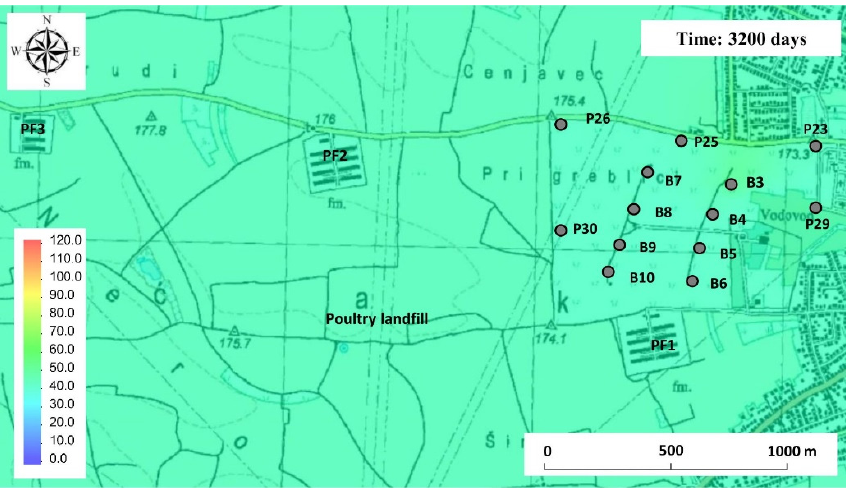
Figure 10. Nitrate pollution propagation by impulse initial conditions—3200 days.